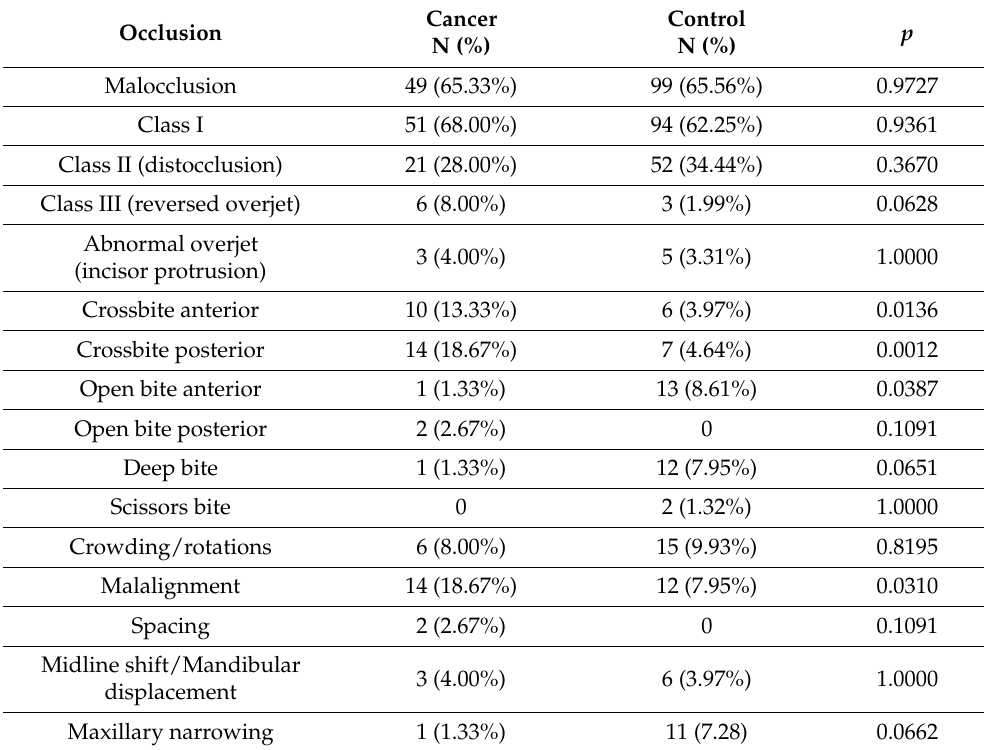
Table 2. Distribution of dental occlusion types in cancer and control